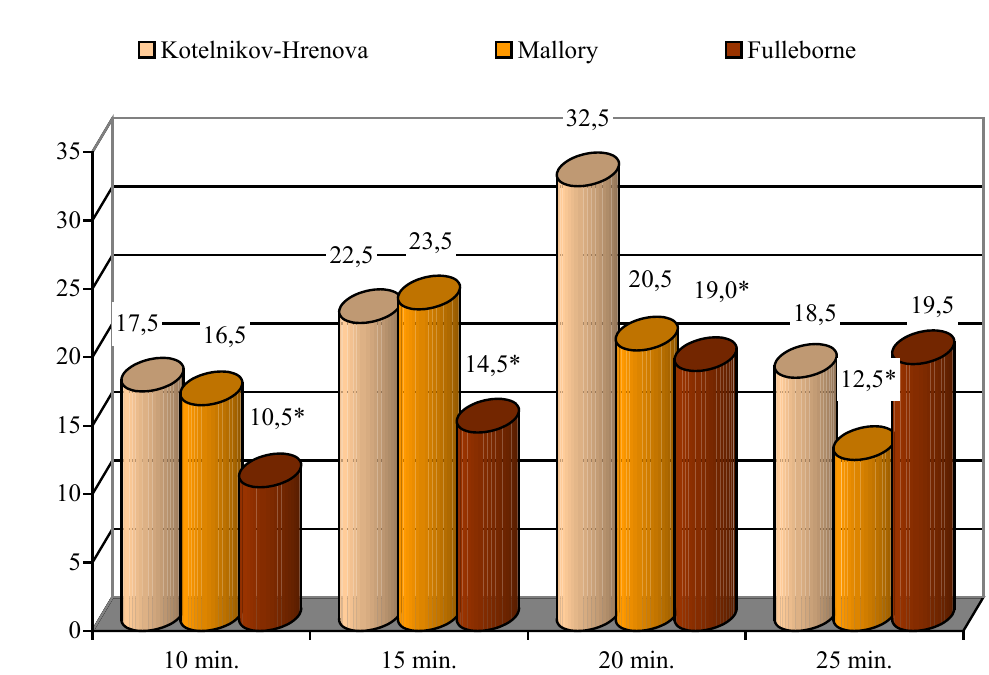
Fig. 2. Efficiency of flotation methods for geese capillary disease